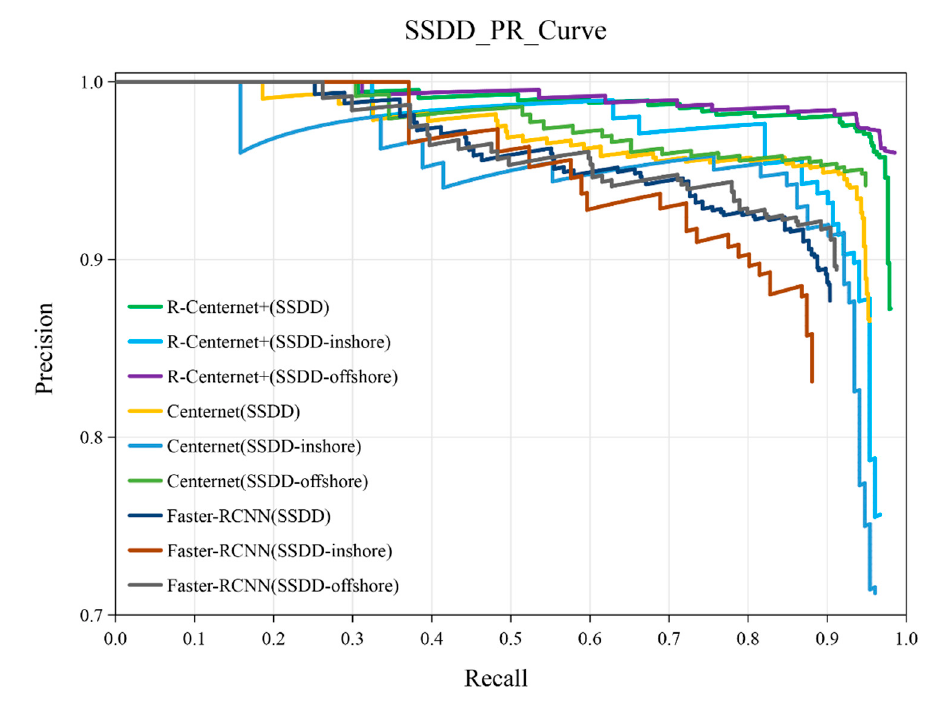
Figure 14. The P-R curves of the SSDD dataset. Table 8. Experimental results on the SSDD dataset.